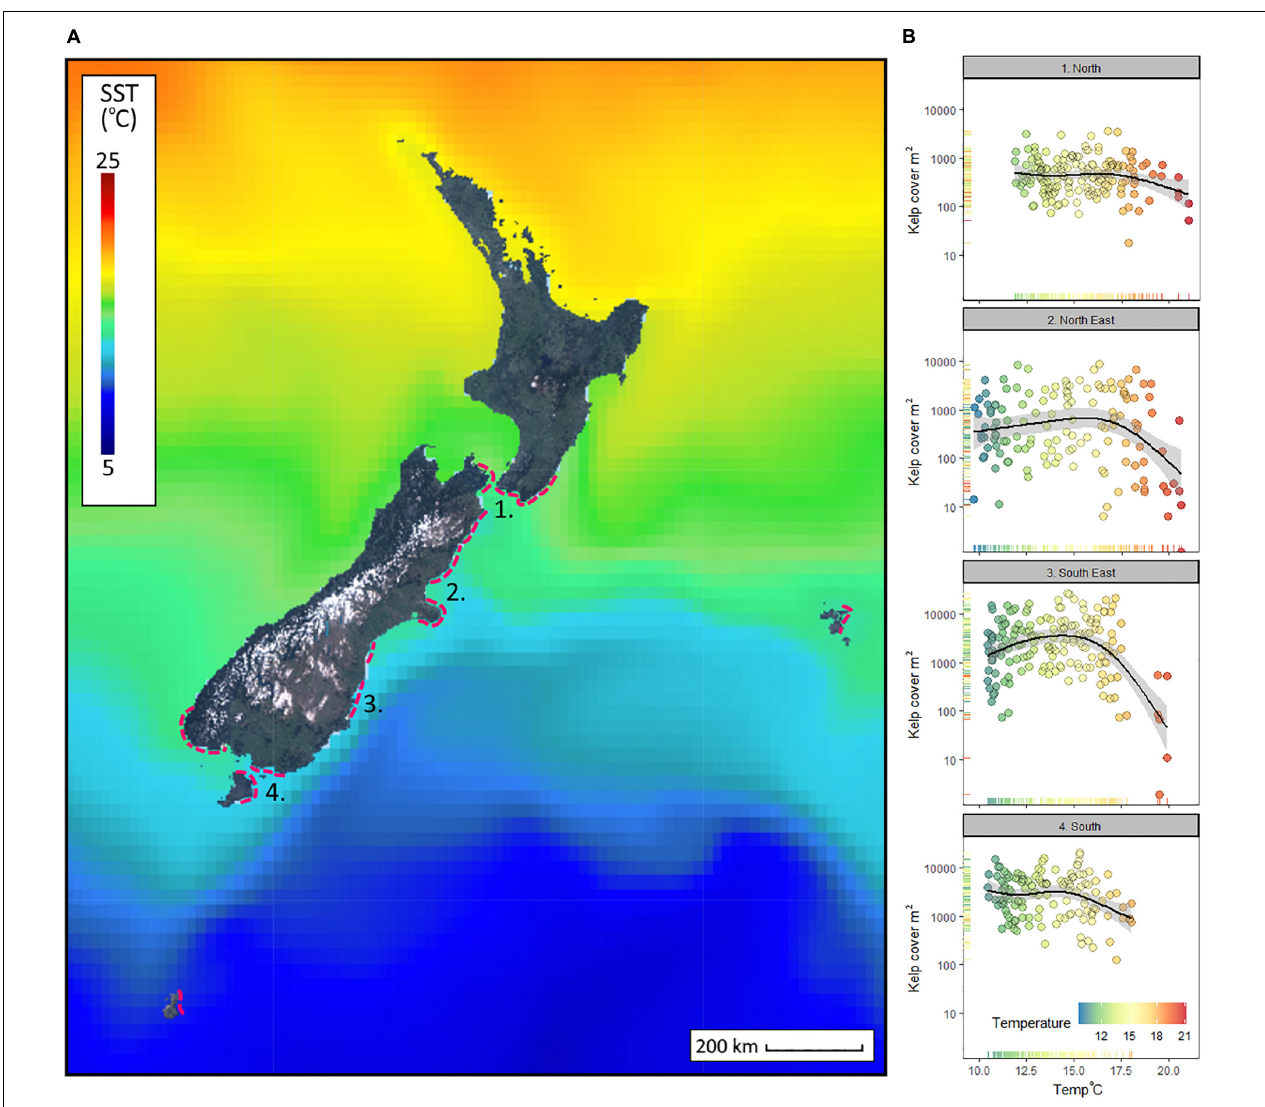
FIGURE 2 | Mean sea surface temperatures (SST) across New Zealand and the South Pacific Ocean between December 2015 and December 2020 (A) , including the known range of Macrocystis in New Zealand (Hay, 1990) as dashed lines; and the monthly response of kelp bed coverage to variation in SST across four regions (B) . Kelp cover (y-axis log transformed) plotted against SST is fitted with generalized additive models (formula y ∼ s[x, k = 5)] including standard error (B) . Temperature anomalies are calculated from the 38 year time series of SST (NOAA OISST